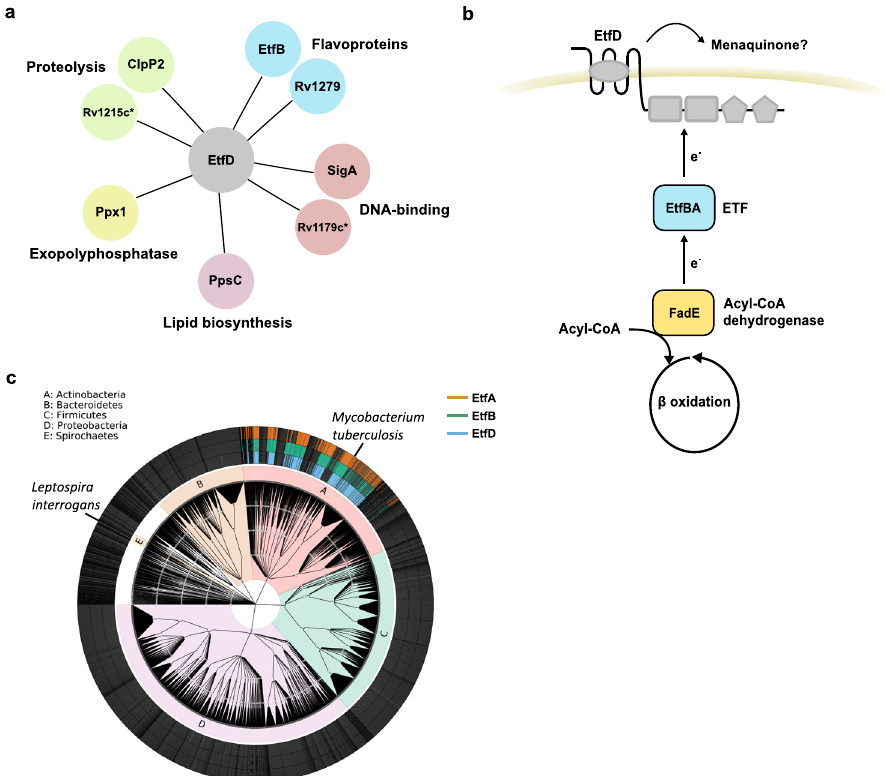
Fig. 5 EtfD and EtfBA interaction and co-occurrence. a EtfD cytoplasmic interactors identi fi ed by protein co-immunoprecipitation. b Model for the pathway constituted by EtfD and EtfBA. c Uniprot bacterial proteome database was surveyed for EtfD and EtfBA putative homologs. The inner ring corresponds to Phyla and the outer rings represent strains with a hit (>30% identity and >75% coverage) for EtfD, EtfB, or EtfA. Asterisk (*) in silico